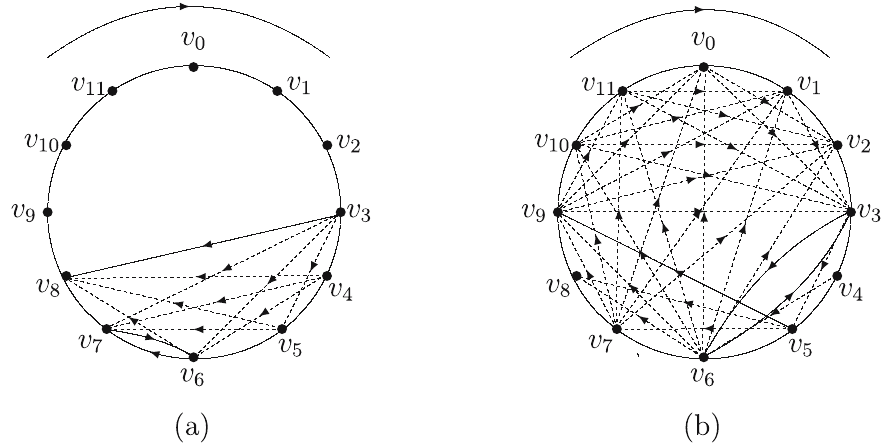
v v i i 1 . (b) There is a vertex set +